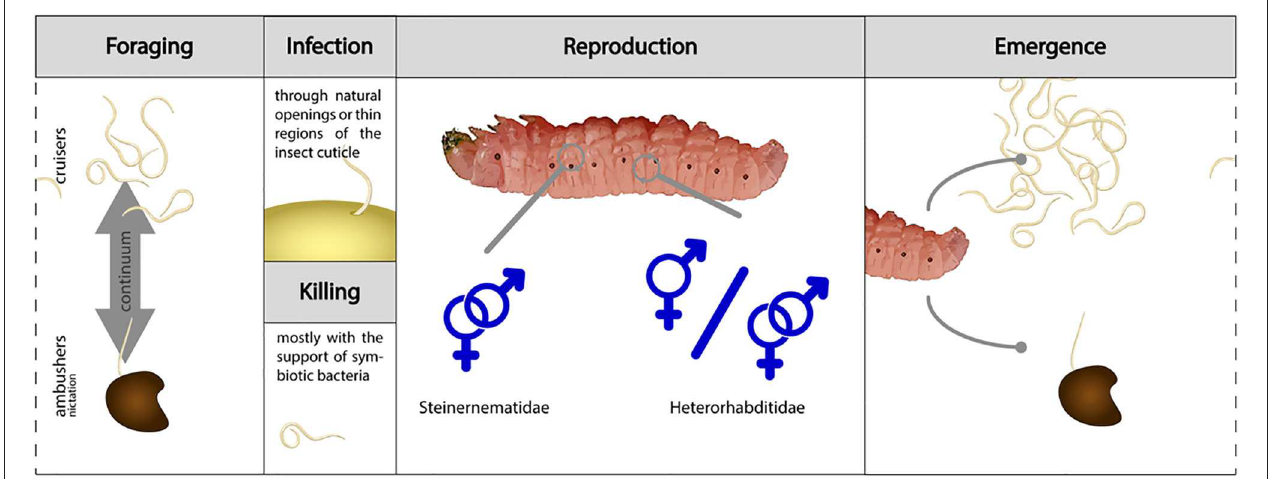
FIGURE 1 | The life cycles of Heterorhabditis and Steinernema entomopathogenic nematodes. Foraging infective juveniles (IJs) can adopt various behaviors spanning from active search for a host (cruiser) to the passive strategy of nictation (ambusher). Once a host has been located and accepted, infection can occur through natural openings or by piercing thin regions of the cuticle. In the hemolymph, IJs release their symbiotic bacteria and the host dies within 24-48h by toxemia and septicemia. EPNs go through up to three generations inside the host cadaver. In most Steinernema spp., adults are always male and females; in Heterorhabditis spp., adults of the first generation are hermaphrodites, whereas following generations contain hermaphrodites, females, and males. When space and food resources become depleted, a new cohort of IJs leaves the host cadaver and starts foraging for a new